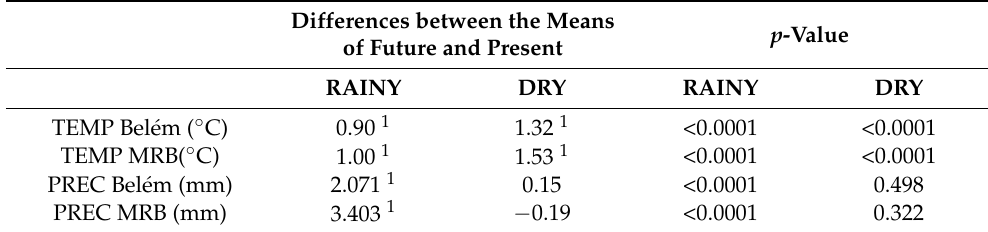
Table A3. Differences between the means of future (2021/20245) and present (1985/2020) for TEMP and PREC in the RAINY and DRY for Bel é m and MRB, and the p -value obtained in Student’s t